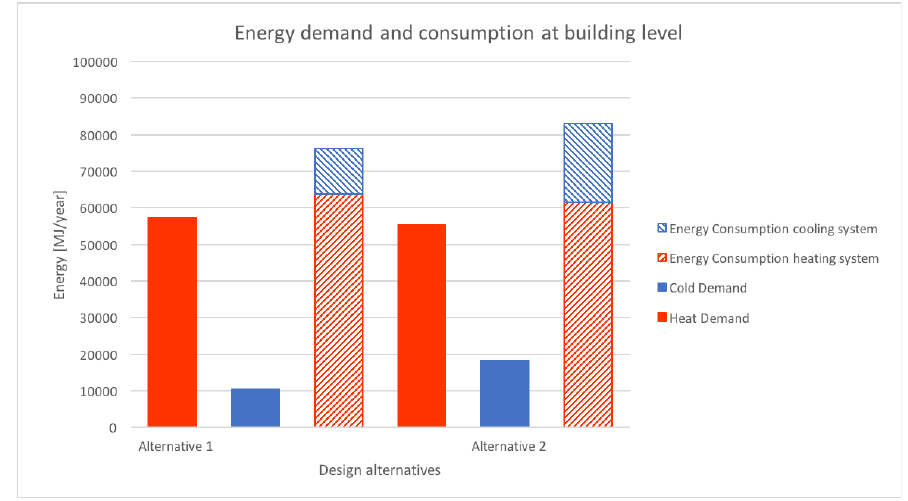
Figure 11. Energy calculation results.